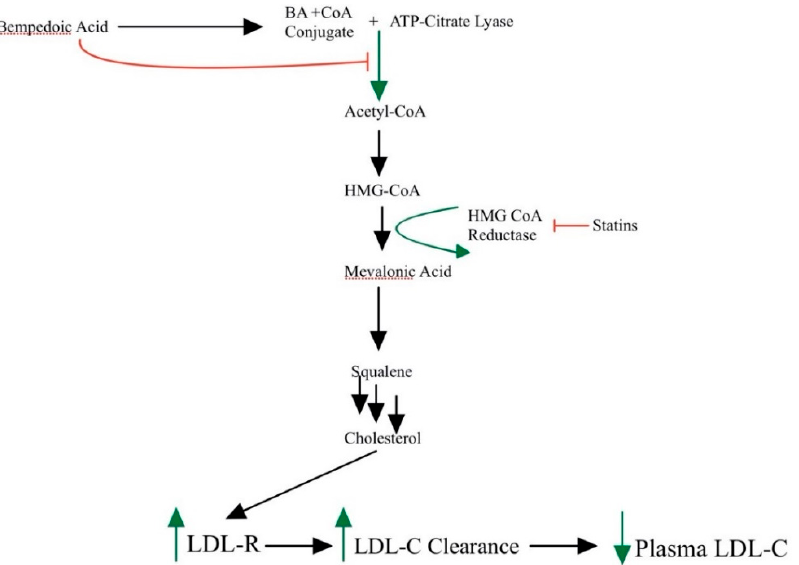
Figure 1. Inhibition of cholesterol synthesis pathway by bempedoic acid and statins. Bempedoic acid inhibits ACL upstream of HMG CoA reductase ( top of figure). Statins inhibit HMG CoA reductase downstream of ACL ( center of figure). BA and statins promote the upregulation of LDL receptors thereby increasing LDL-C clearance and reducing plasma LDL-C ( bottom of figure). ACL, ATP citrate lyase; BAA, bempedoic acid; HMG-CoA, β -hydroxy β -methylglutaryl-CoA; LDL-C, low-density lipoprotein cholesterol; LDL-R, low-density lipoprotein receptor.